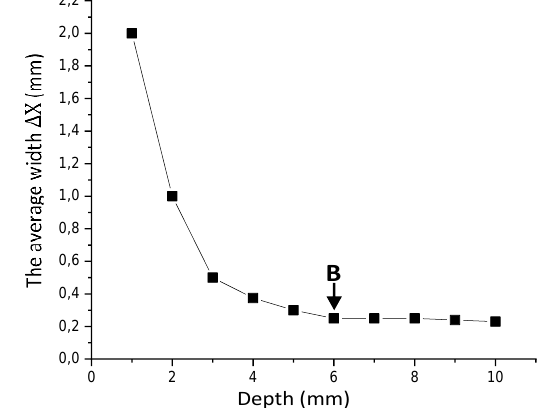
FIGURE 15 The average width as a function of the crack